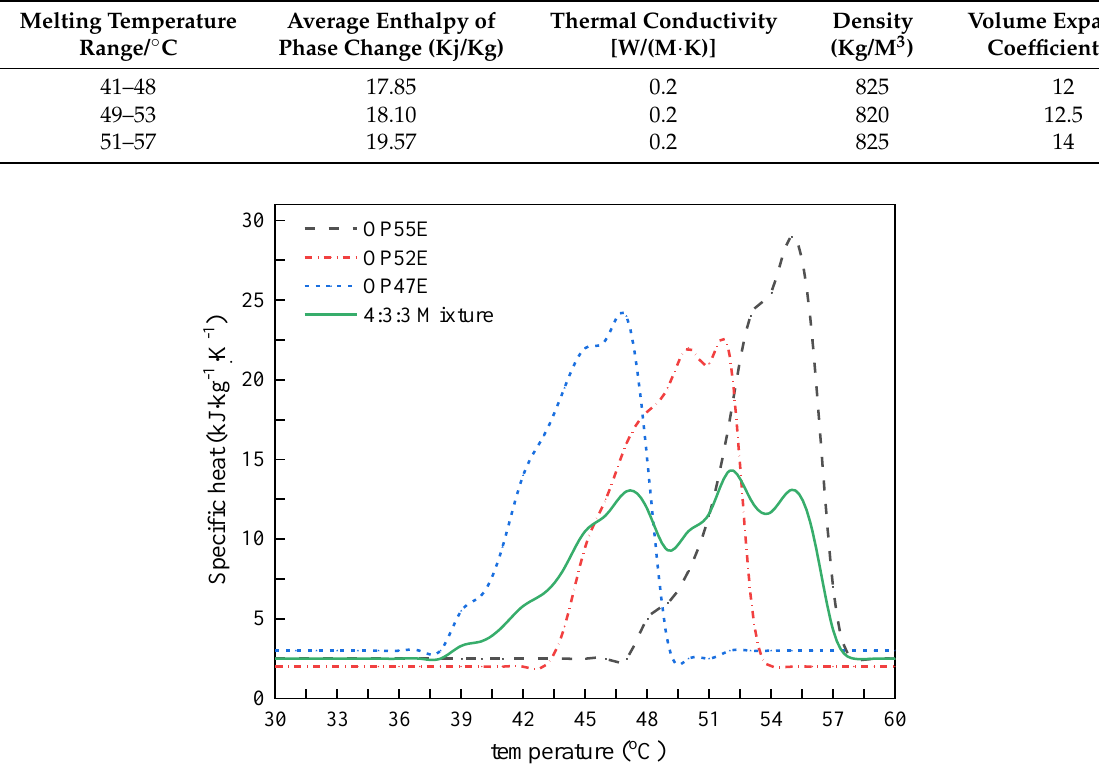
Figure 3. Specific heat of different phase change materials.